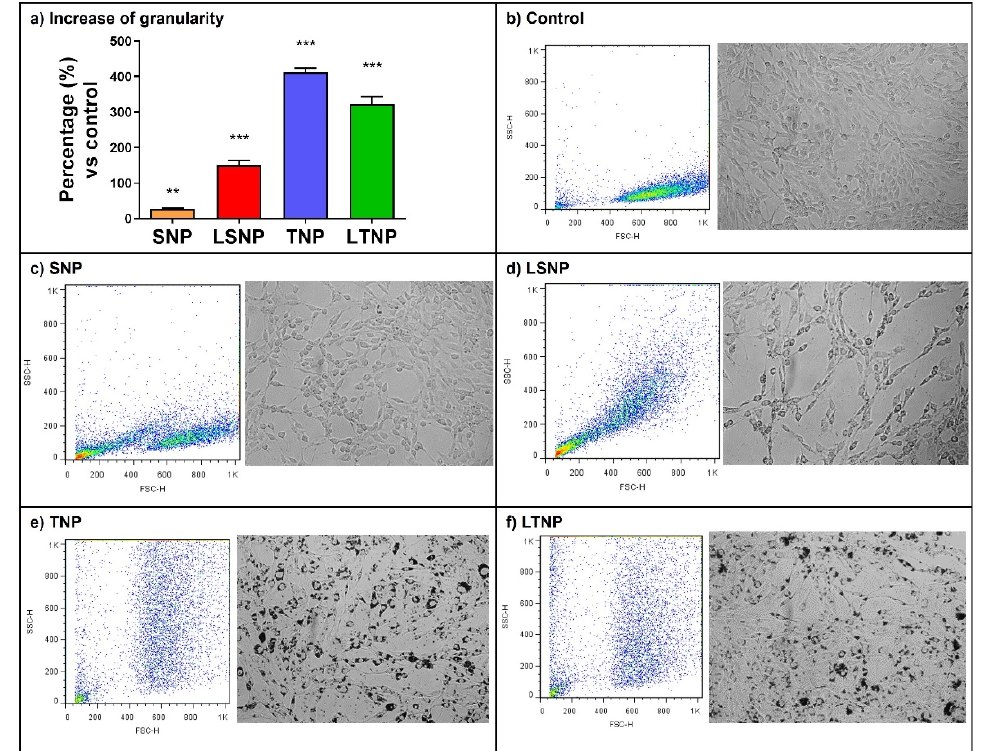
Figure 4. Nanoparticle treatment increases the granularity of C6 cells. Cells were treated with 100 µg/mL of nanoparticles for 24 h and analyzed by flow cytometry, obtaining the mean granularity. ( a ) Percentage increase in the granularity of treated cells, bars show mean ± SEM of three independent experiments in triplicate, n = 9 (statistical analysis with one-way ANOVA after logarithmic transformation, ** p < 0.001 and *** p < 0.0001 vs. control). Representative dot plots (left) and bright-field images (right) of treated C6 cells: ( b ) untreated control, ( c ) SNP, ( d ) LSNP, ( e ) TNP, ( f ) LTNP.